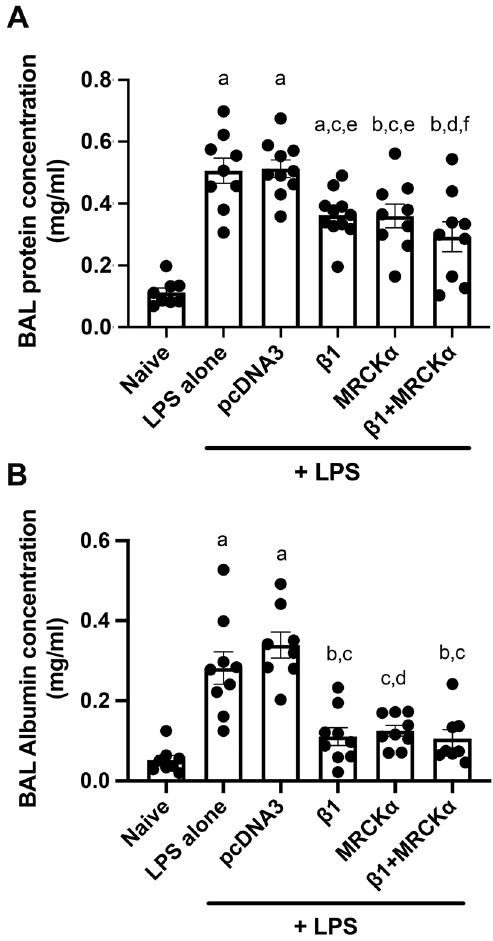
Figure 9. MRCKα gene transfer reduces BAL protein levels in previously injured mice. Lung injury was established in C57B6 mice (n = 8–9) by aspiration of LPS (5 mg/kg) and 1 day later plasmids (100 µg each) expressing either no insert (pcDNA3), the β1 subunit of the Na + ,K + -ATPase (β1), MRCKα, or β1 and MRCKα were delivered in 50 µl to the lungs by aspiration followed immediately by electroporation (8 pulses of 10 ms duration each and 200 V/cm). Naïve mice (n = 5) received no LPS or DNA. Two days later (3 days after LPS administration), lungs were lavaged with PBS and BAL fluid was collected and analyzed for total protein content, shown as mean ± SEM ( A ). All experiments were carried out three times and a representative experiment is shown. One-way ANOVA with post-hoc Tukey’s multiple comparisons was used for statistical analysis; a, p < 0.0001 compared to naïve; b, p < 0.01 compared to naïve; c, p < 0.05 compared to LPS; d, p < 0.001 compared to LPS; e, p < 0.05 compared to pcDNA3; f, p < 0.001 compared to pcDNA3. The concentration of albumin in the BAL fluid was quantified by ELISA and shown as mean ± SEM ( B ). One-way ANOVA with post- hoc Tukey’s multiple comparisons was used for statistical analysis; a, p < 0.001 compared to naïve; b, p < 0.001 compared to LPS; c, p < 0.0001 compared to pcDNA3; d, p < 0.01 compared to